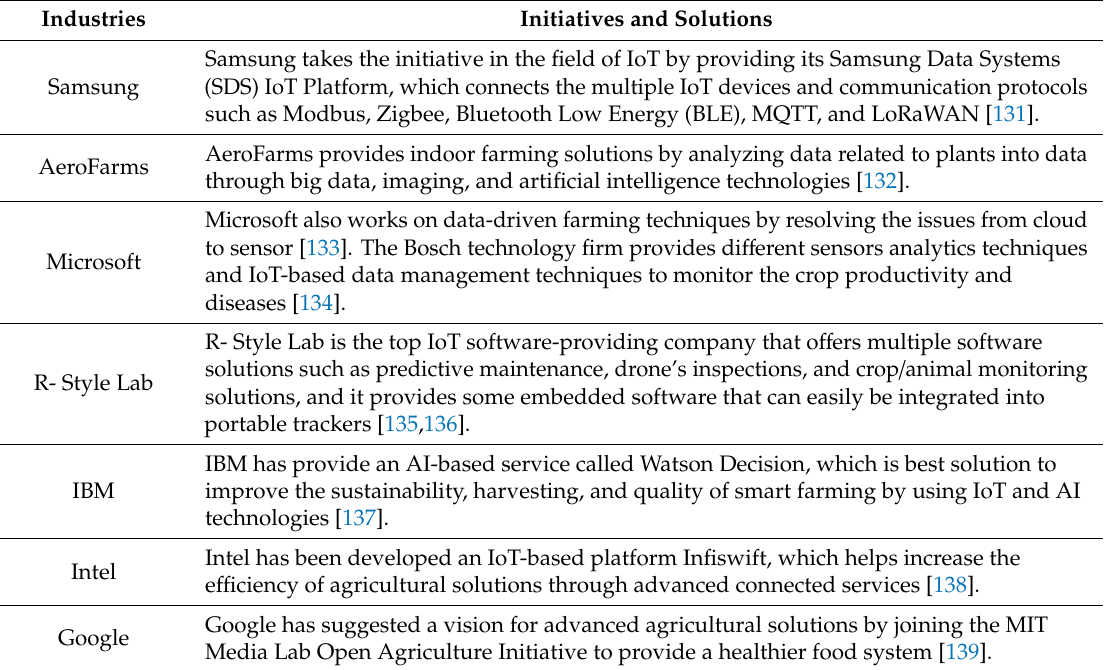
Table 10. Available solutions and initiatives regarding IoT in